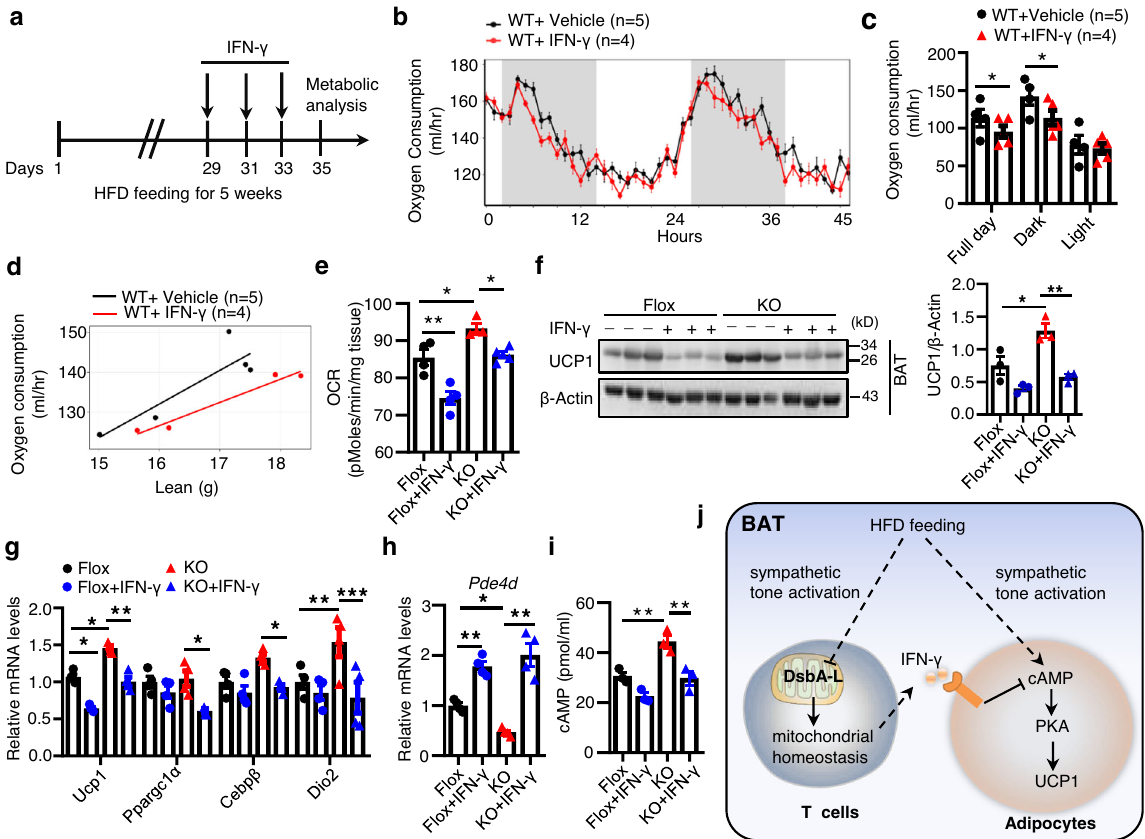
Fig. 7 Administration of IFN- γ reverses the enhanced BAT thermogenesis in HFD-Fed DsbA-L CD4-KO mice. a Schematic for IFN- γ dosing and metabolic analyses IFN- γ (100 μ g/kg) was injected intraperitoneally every other day for the last week. b The oxygen consumption of wild-type mice fed an HFD for 5 weeks with ( n = 4) or without IFN- γ ( n = 5) administration for the last week. c The average oxygen consumption shown in b . d ANCOVA analyses of average VO 2 (ml/h) in c by lean mass were shown. e The basal OCR of BAT collected from DsbA-L CD4-KO mice and control littermates fed an HFD for 5 weeks with ( n = 4 – 5/group) or without IFN- γ ( n = 4/group) treatment for the last week. f Western blot analyses of PGC1 α and UCP1 levels in BAT of DsbA-L CD4-KO mice and control littermates fed an HFD for 5 weeks with or without IFN- γ treatment for the last week. ( n = 3/group). g mRNA levels of thermogenic genes in BAT of DsbA-L CD4-KO mice and control littermates fed an HFD for 5 weeks with or without IFN- γ treatment for the last week. ( n = 4/ group). h The mRNA levels of PDE4D in BAT of DsbA-L CD4-KO mice and control littermates fed an HFD for 5 weeks with or without IFN- γ treatment for the last week. ( n = 4/group). i cAMP levels accumulated in BAT of DsbA-L CD4-KO mice and control littermates fed an HFD for 5 weeks with or without IFN- γ treatment for the last week. ( n = 3/group). j A proposed model of the mechanism by which T cell DsbA-L regulates energy expenditure in BAT. A diet- induced signal stimulates the sympathetic nerve system and downstream cAMP-PKA activation to promote UCP1 expression in BAT. Meanwhile, HFD feeding leads to decreased DsbA-L expression in BAT-resident T cells. DsbA-L de fi ciency blocks T cell mitochondrial function and decreases IFN- γ - producing Th1 and CD8 + T cells accumulation in BAT. IFN- γ could act on brown adipocytes and inhibit UCP1 expression and cAMP accumulation via promoting PDE4D expression. Decreased IFN- γ production in BAT thus contributes to enhanced diet-induced BAT thermogenic capacity and alleviating over obesity. Data shown are representative of three independent experiments. All data are presented as mean ± SEM. Statistical values p < 0.05 (*), p < 0.01 (**), p < 0.001 (***) are determined by ANOVA adjusted for multiple comparisons ( e , f (right panel), g – i ) or ANCOVA test ( c ). Source data are provided as a Source Data